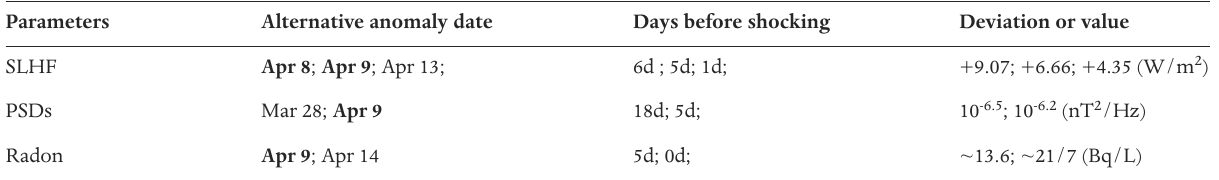
Table 1. Multiple parameters anomaly alternative date and deviation (or